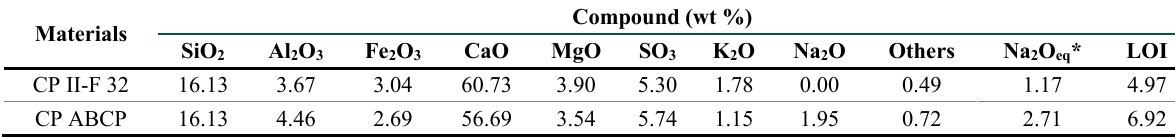
Table 1. Chemical composition, in oxides, of the cements